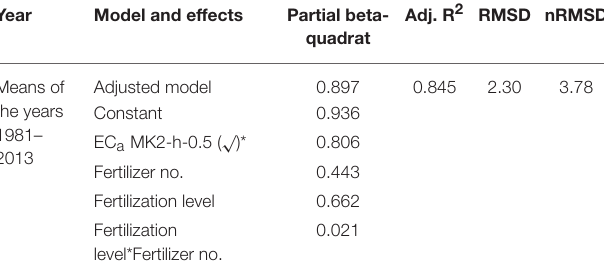
TABLE 6 | Modeling of the yield (means of the years 1981–2013) with ANCOVA with the factors fertilization level and fertilizer number and the covariates EC a , topographic parameters, and coordinates (further information is contained in Supplementary Table 3 ).